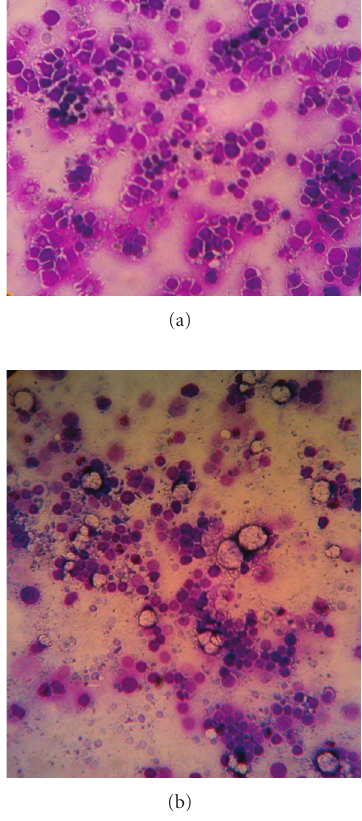
Figure 4: (a) Leishman staining of bone marrow smear showing densely packed cellular distribution in normal condition. (b) Leish- man staining of Aplastic bone marrow smear exhibiting frequent appearance of large fat cells (adipocytes) with empty spaces.